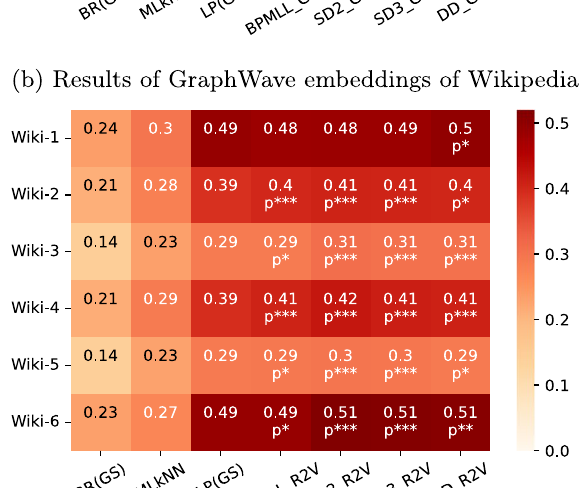
Fig. 4 Results of Wikipedia